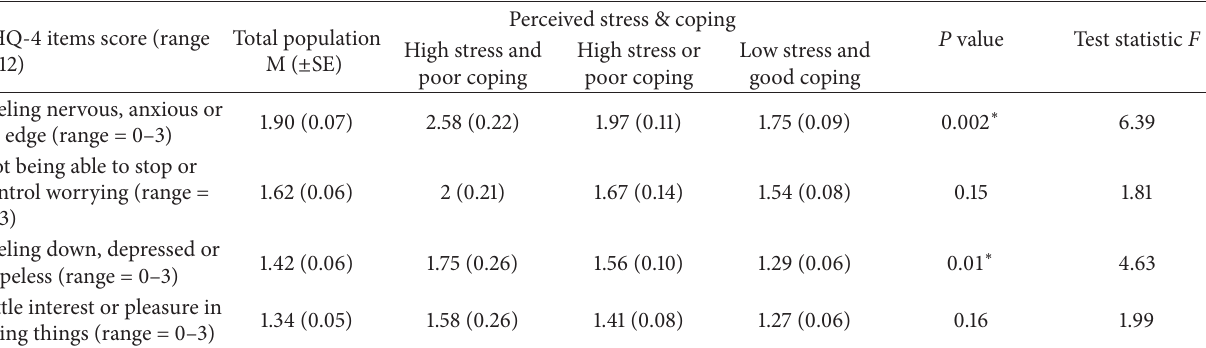
Table 5: Depression and anxiety symptoms score comparison by stress and